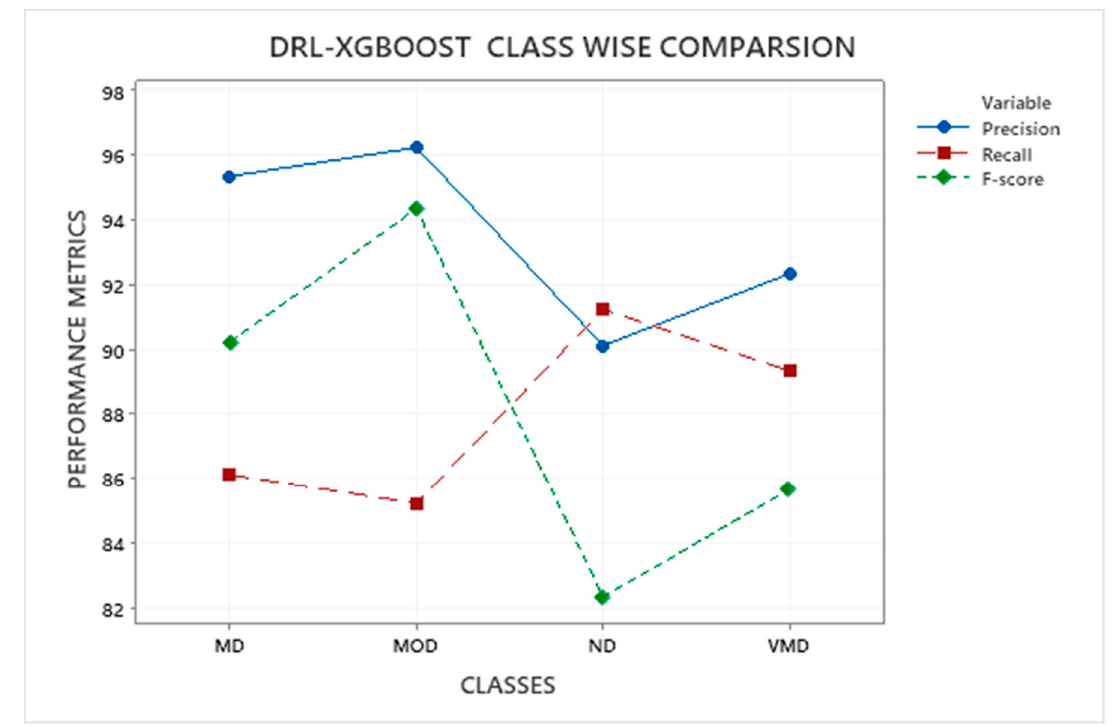
Figure 6. RL-XGBOOST Class Comparison. Table 5. Accuracy and precision of existing approaches.